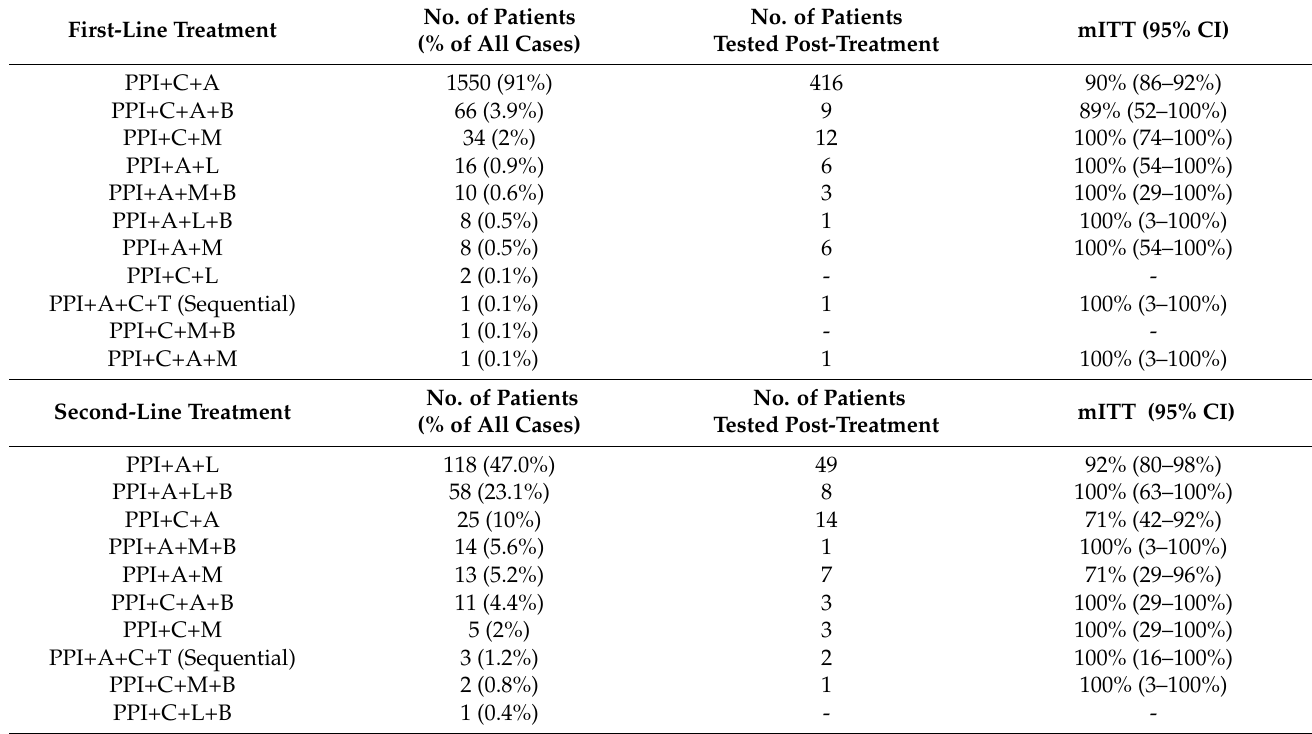
Table 1. First and second-line prescriptions and their modified intention-to treat (mITT) effectiveness. A—amoxicillin; B—bismuth; C—clarithromycin; L—levofloxacin; M—metronidazole; PPI—proton pump inhibitor; T—tinidazole; 95% CI—95% confidence